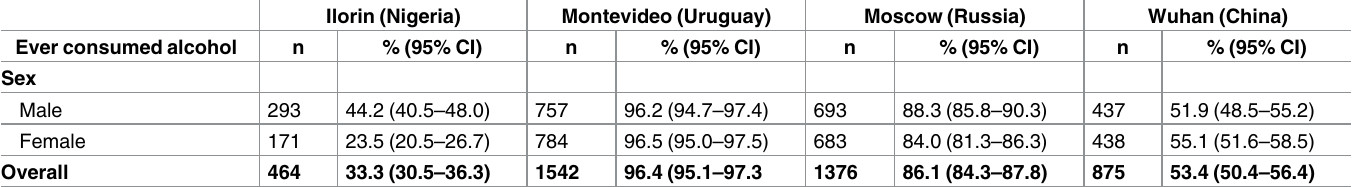
Table 1. Ever consumed alcohol (by gender) by city/country.